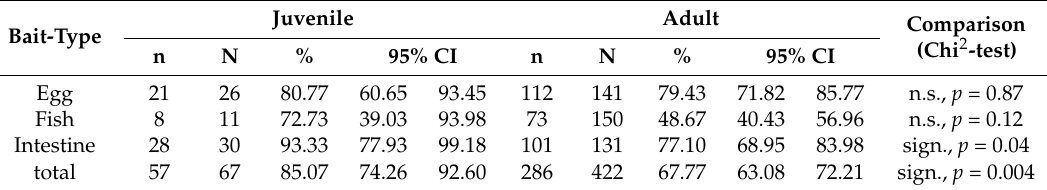
Table 6. Bait acceptance and the age-group (juvenile, adult) of the dogs. Only a few puppies were offered a bait and therefore they were not included in the analysis (n = number of baits accepted,